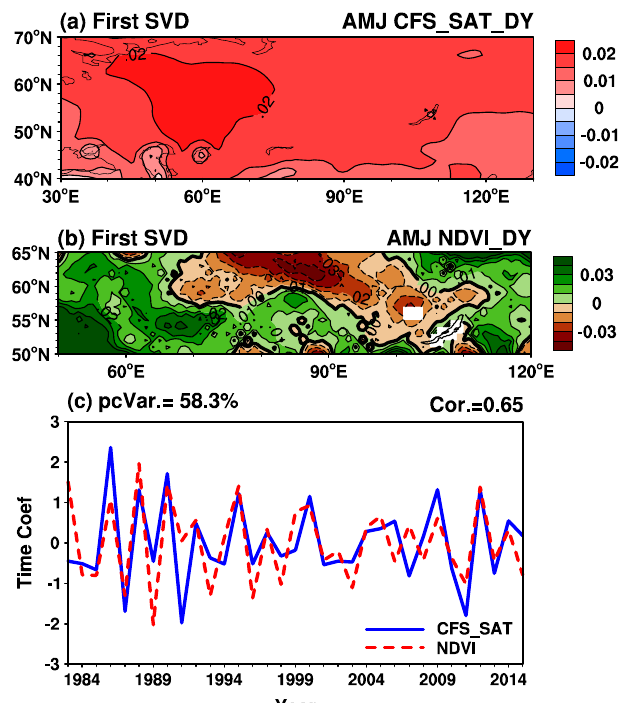
Figure 2. Spatial patterns for the first paired mode of the difference in years (DY) of ( a ) spring (April–May–June (AMJ)) surface air temperature (SAT) from CFSv2 and ( b ) spring Eurasian NDVI (NDVIEA) via a singular value decomposition (SVD) analysis during 1983–2015. ( c ) The corresponding normalized time series of the expansion coefficients for the paired mode; their correlation coefficient is shown above the top right-hand corner, and the variance explained by the first mode is shown above the top left-hand corner.